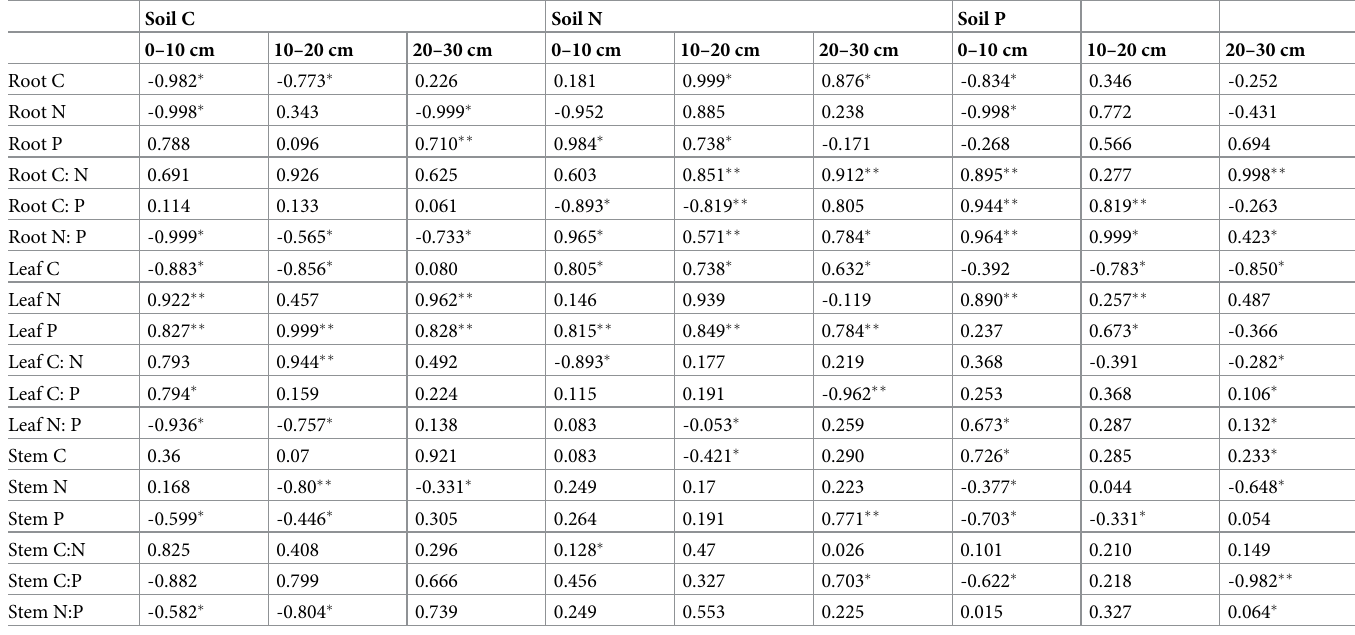
Table 2. Pearson correlation analysis (2- tailed) result between soil ecological stoichiometry and plant nutrients in root, stem and leaf along the depth gradients. Soil C Soil N Soil